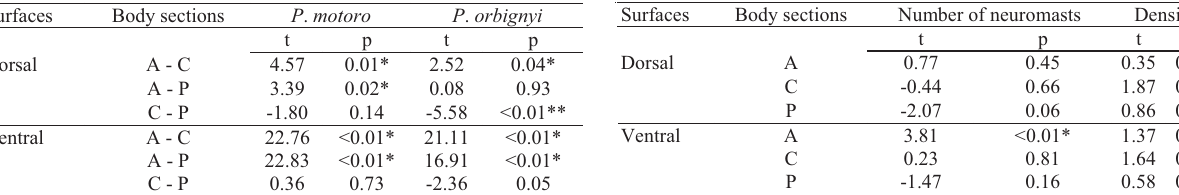
among these species.